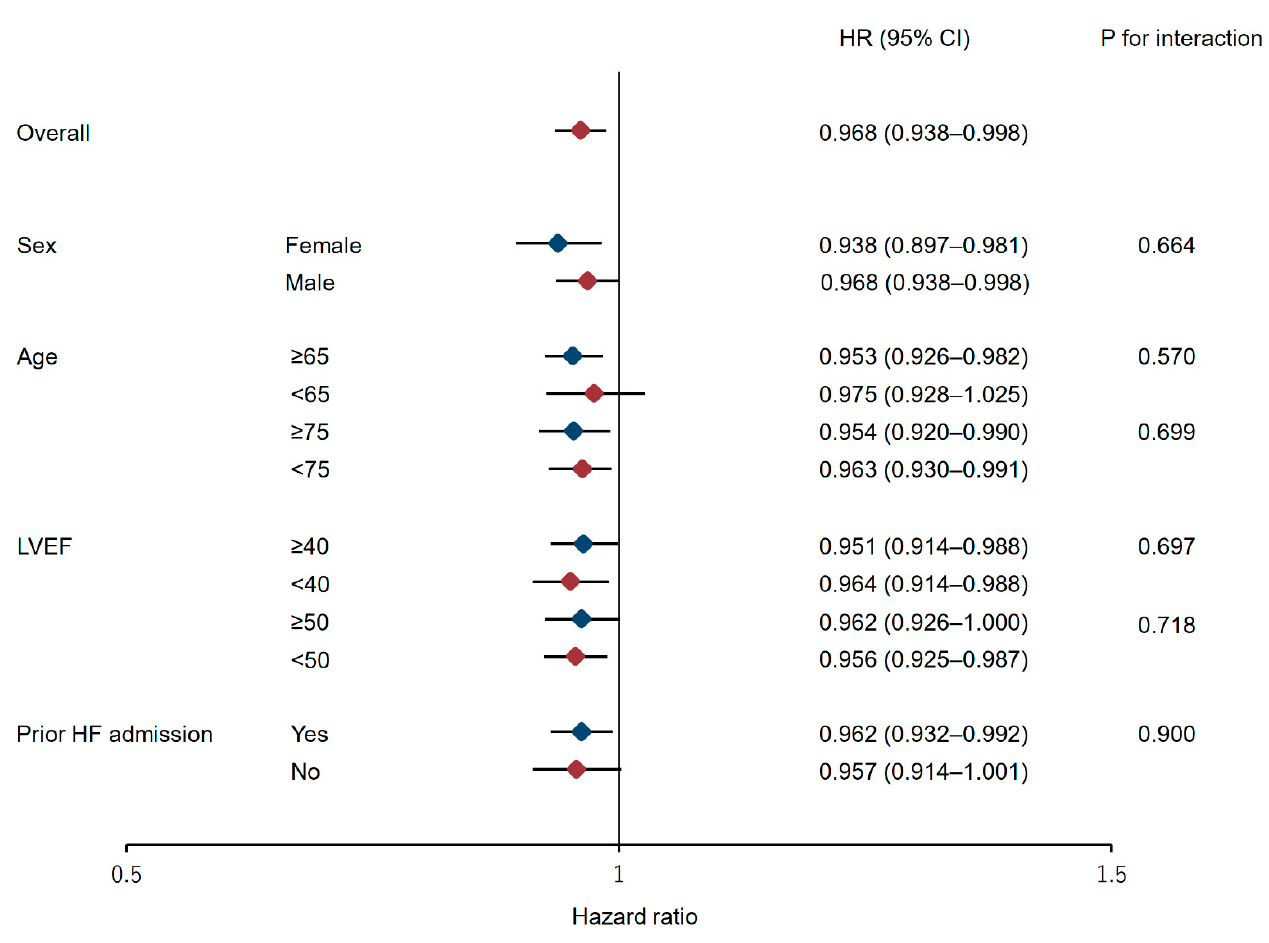
mortality. All subgroups were adjusted for age, sex, body mass index, New York Heart Association